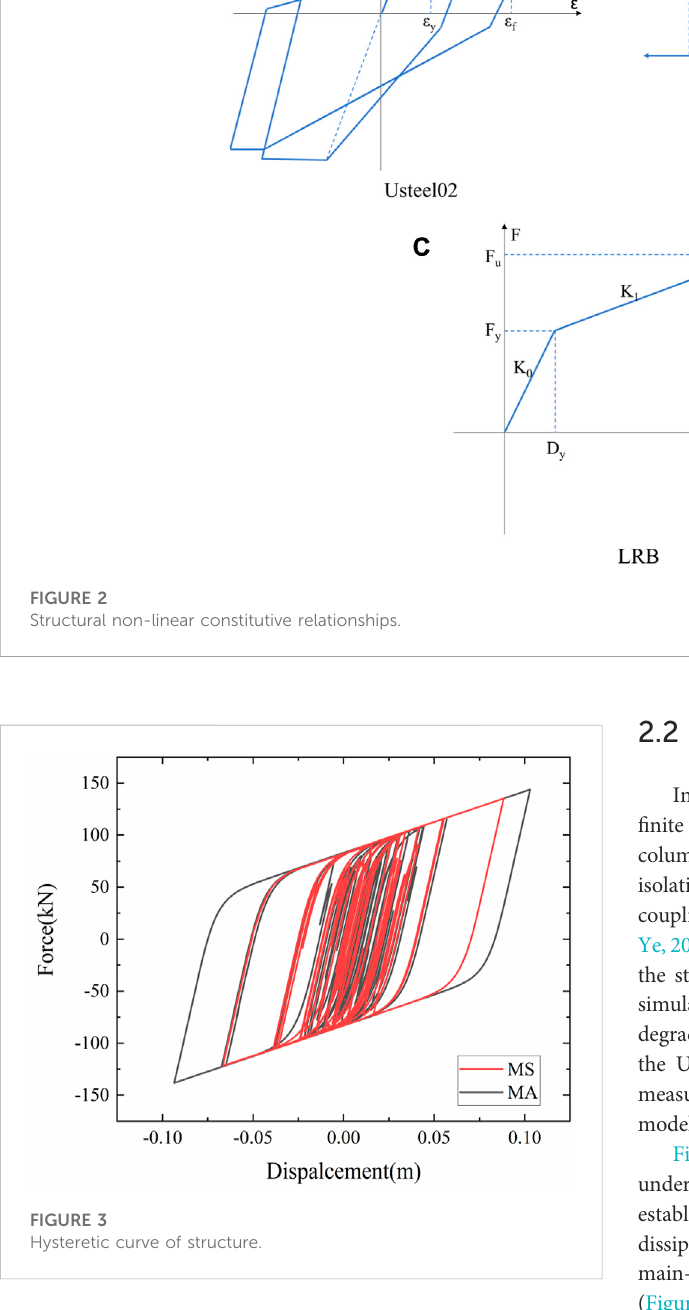
story, and the fi rst-order vibration period of the story isolation structure was 2.74 s. The plane and vertical layout of the structure is shown in Figure 1. A rubber LRB600 isolation bearing was used with a thickness of 110 mm, vertical stiffness of 1581 kN/mm, pre-yield stiffness of 11.507 kN/mm, post-yield stiffness of 0.886 kN/mm, and a yield force of 90 kN.